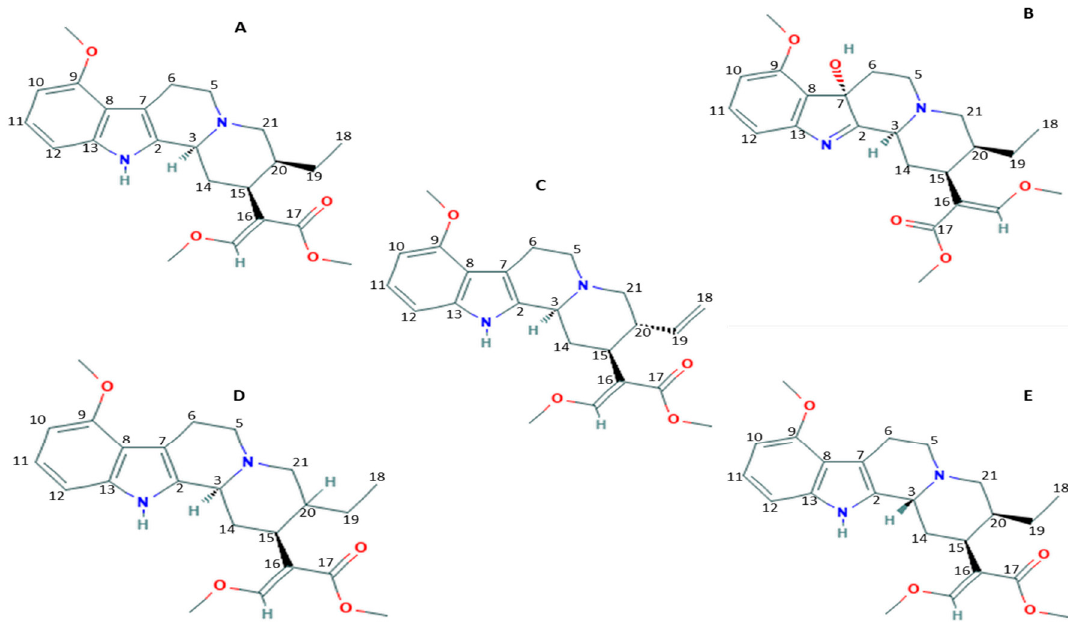
Figure 1. Structures of secondary metabolites: ( A ) mitragynine, ( B ) 7-hydroxymitragynine (7-HMG), ( C ) paynantheine (PAY), ( D ) speciogynine (SG) and ( E ) speciociliatine